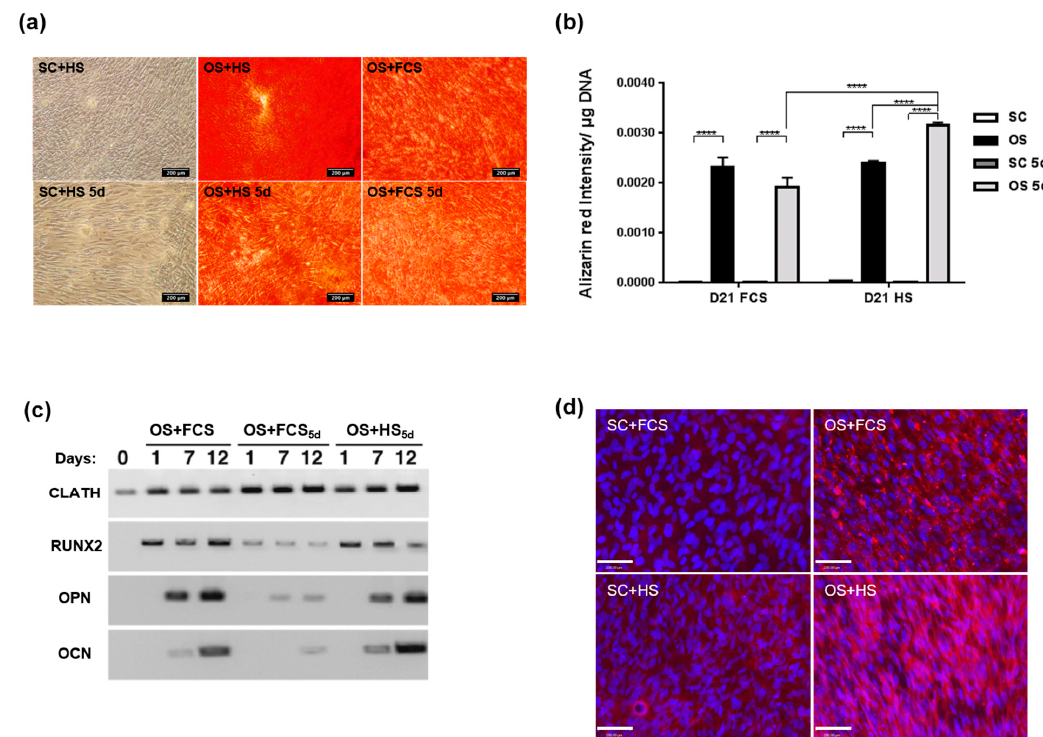
Figure 5. Osteogenic response of human mesenchymal stem cells in the presence of FCS or HS. ( a ) Representative images of Alizarin red staining in MSCs cultures after 21 days in constant and transient HS media compared to constant FCS. ( b ) Quantitation of Alizarin Red staining intensity at day 21. **** p < 0.00005 ( n = 6). ( c ) RT-PCR expression analysis of the osteogenic markers RUNX2, Osteopontin (OPN), and Osteocalcin (OCN) assessed at day one, seven and 12 after the onset of osteogenic treatment. ( d ) Representative images of Osteocalcin immunodetection ( pink ) in MSCs cultured for 21 days in SC or OS media with FCS or HS, with dapi nuclear counterstain ( blue ). Scale bar = 200 µm.